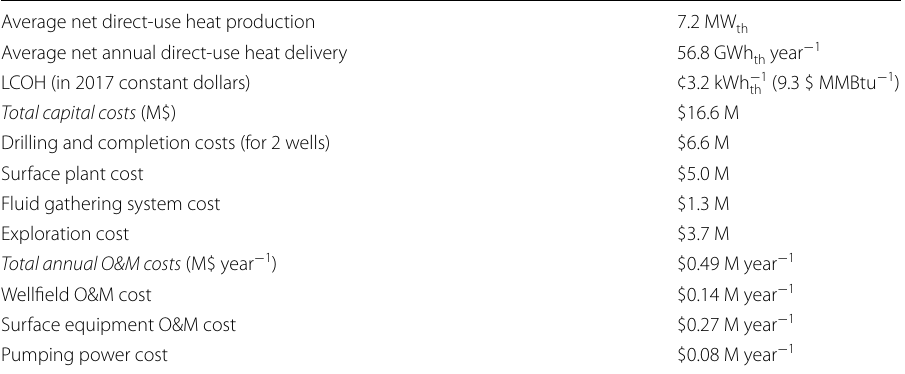
Table 2 GEOPHIRES output results for example simulation 1 Average net direct-use heat